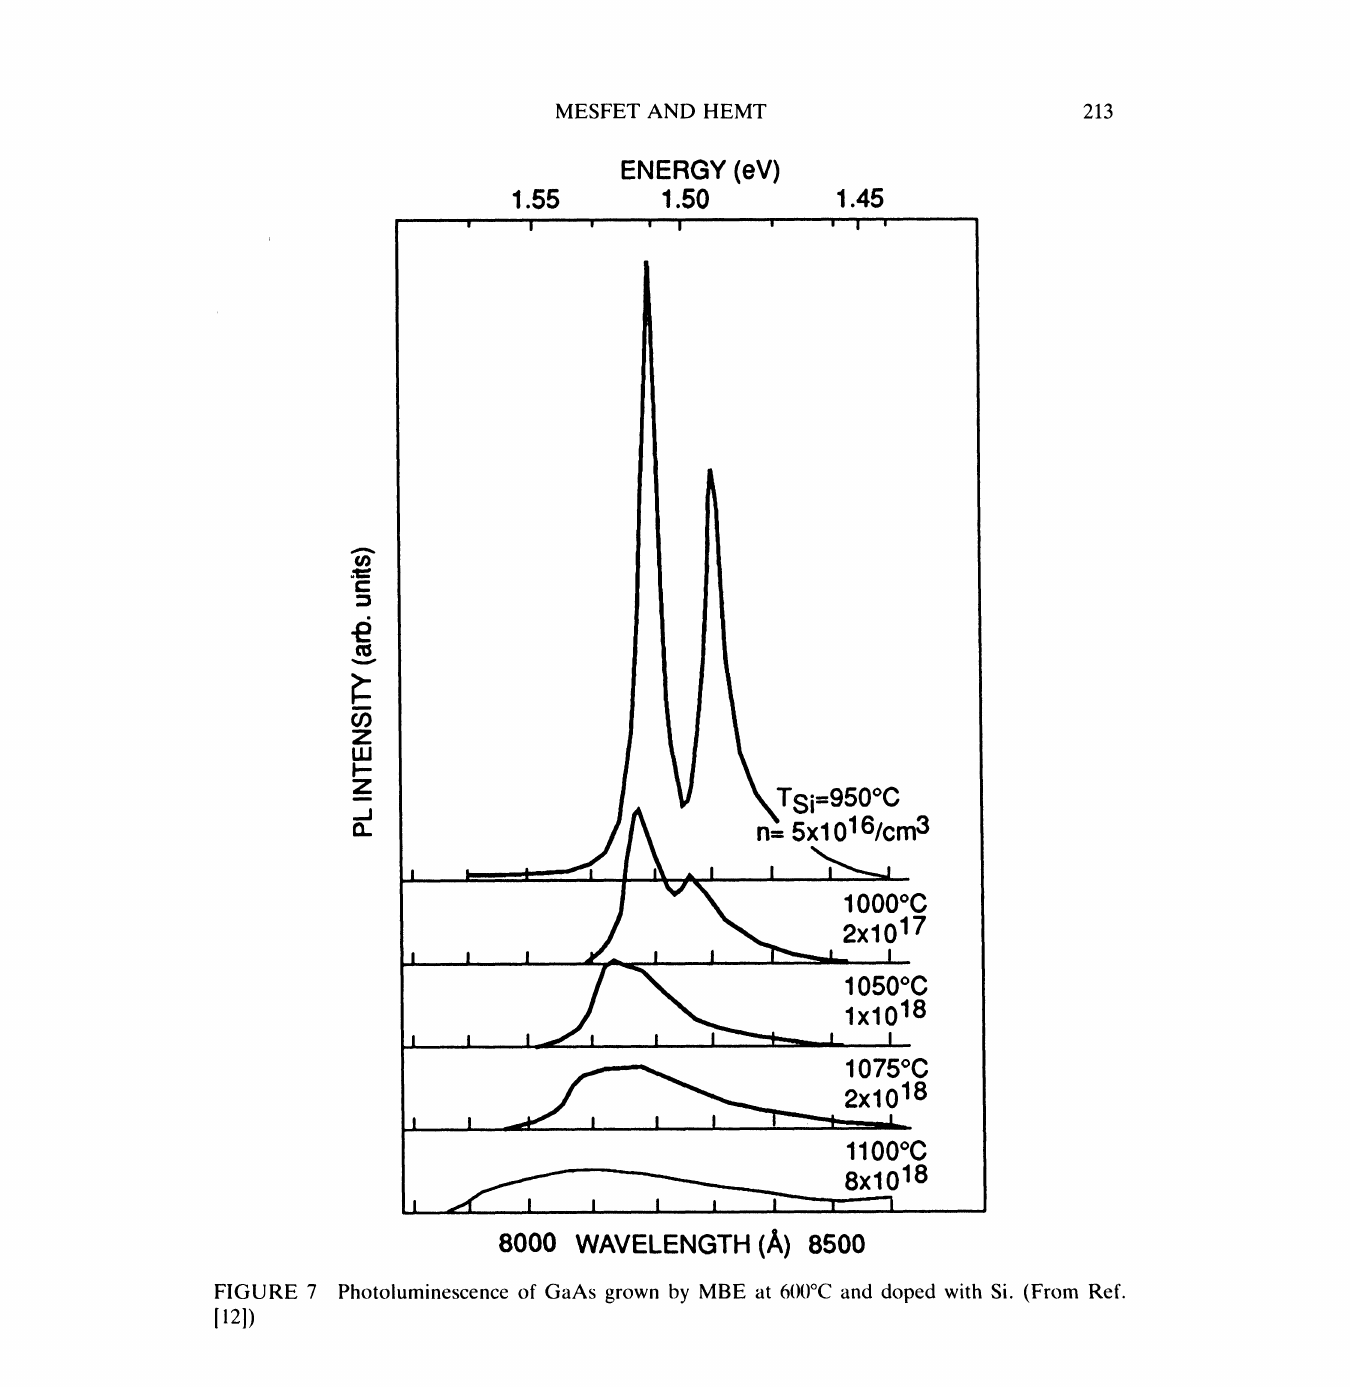
FIGURE 7 Photoluminescence of GaAs grown by MBE at 600C and doped with Si. (From Ref.